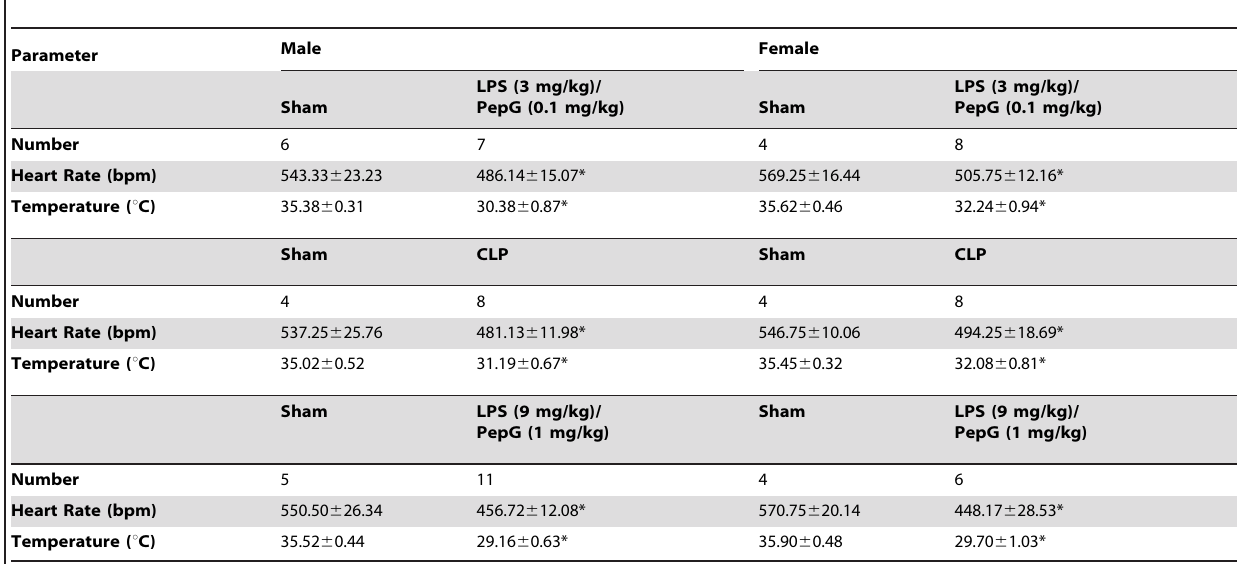
Table 1. Gender dimorphism of heart rate and temperature of mice responses to septic insults.